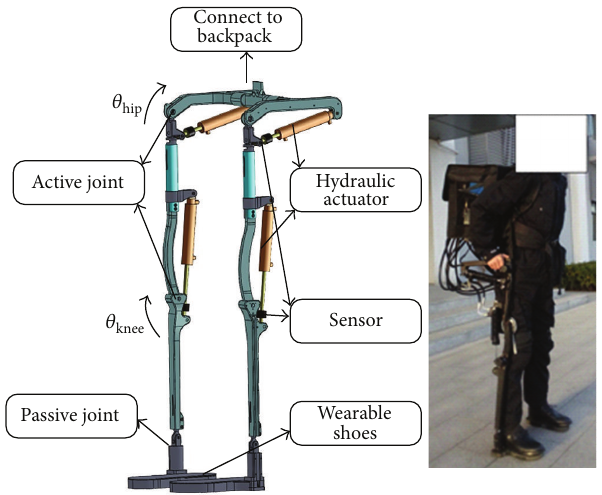
Figure 1: Prototype of lower limb powered exoskeleton. There are two active joints of each leg in walking direction, which are represented as 𝜃 hip and 𝜃 knee . All auxiliary facilities are packaged in the